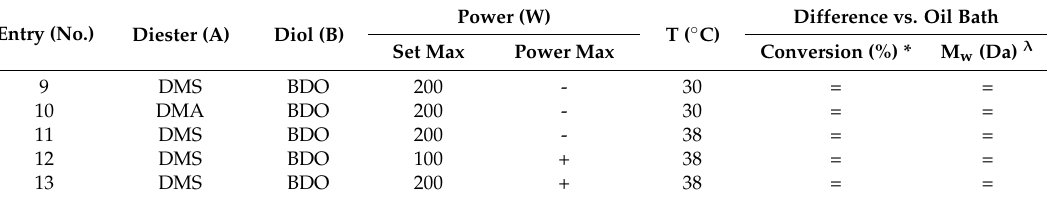
Table 2. Reactions in organic media catalyzed by Novozym 435 ® after 4 h of reaction.